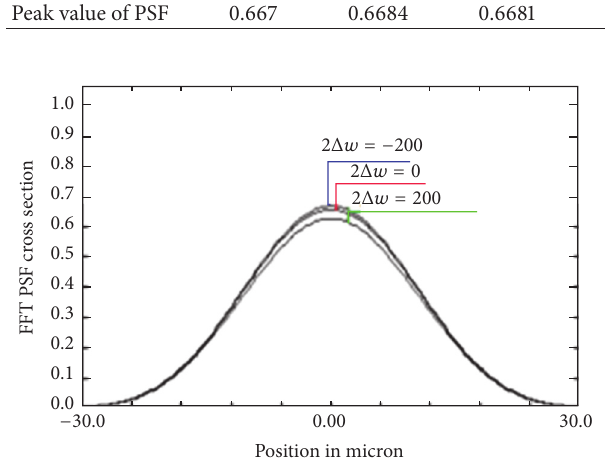
Figure 8: FFT PSF cross